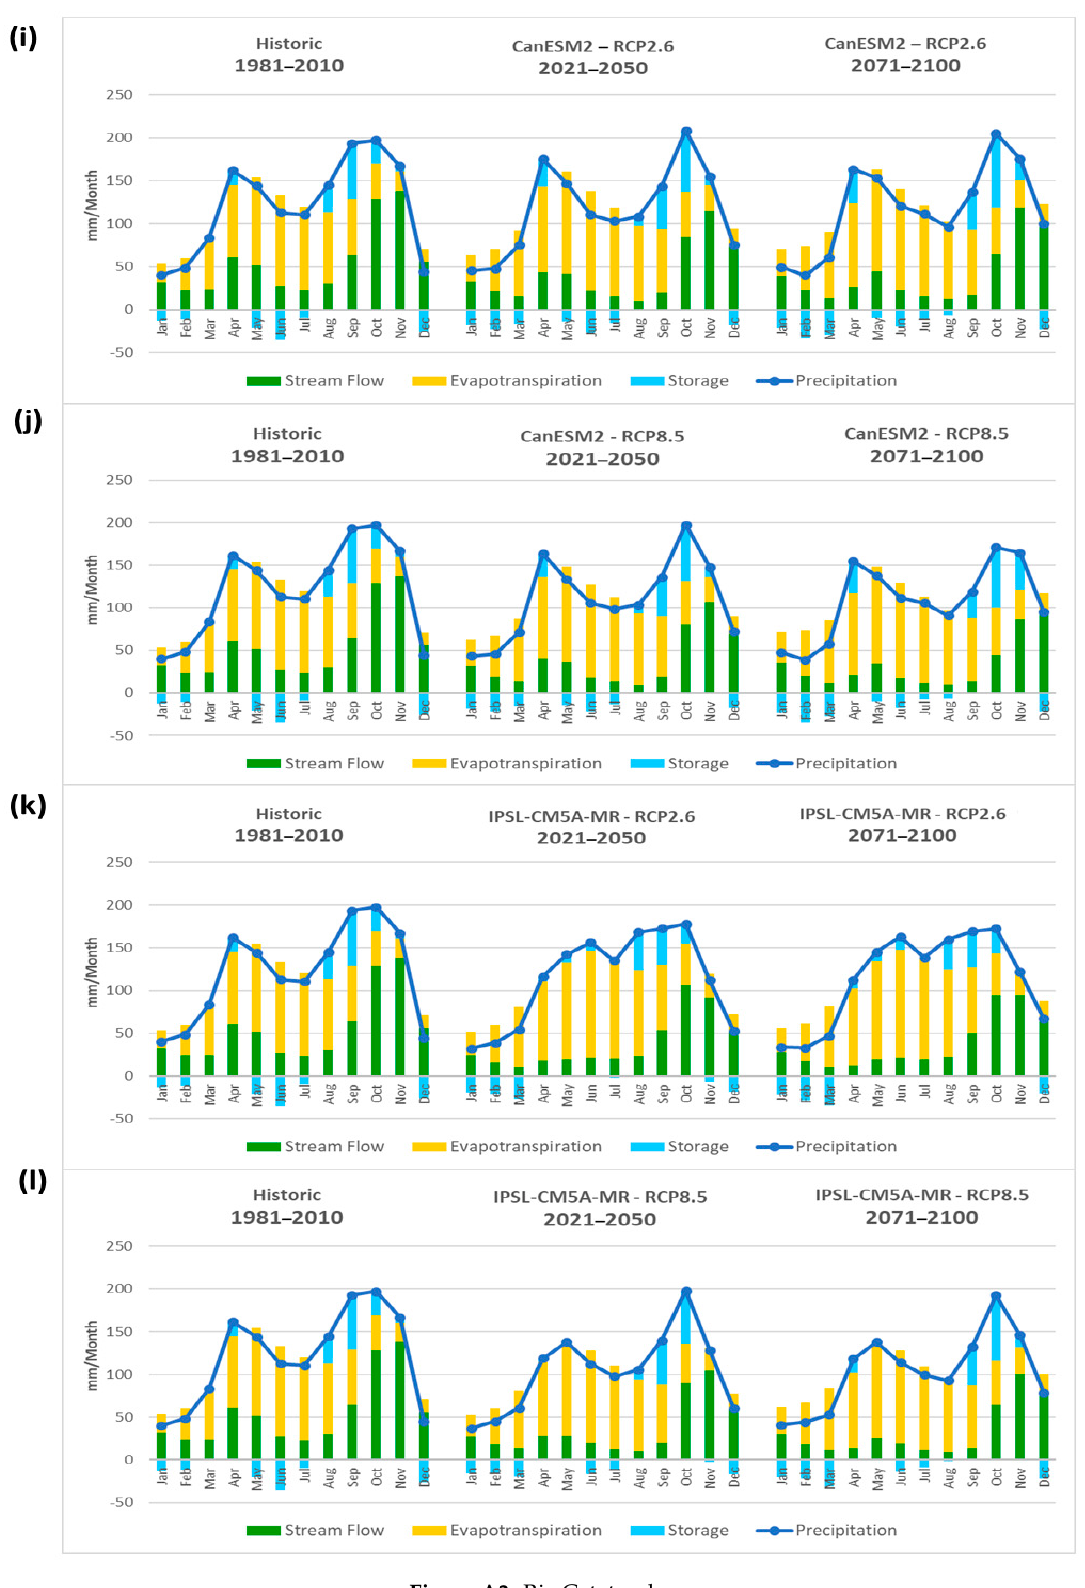
Figure A3. Rio Figure A3. Rio Catatumbo